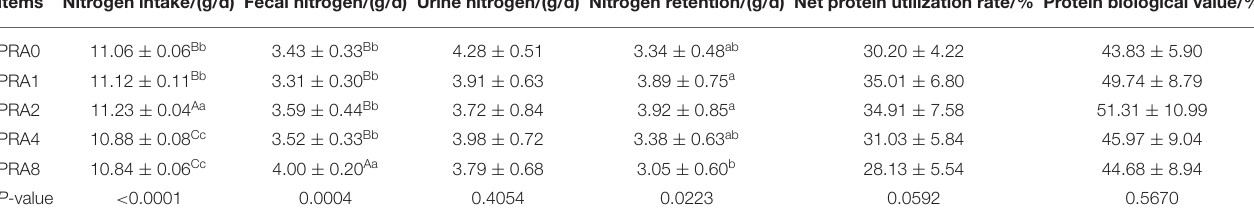
TABLE 4 | Effects of dietary PRA extract levels on nitrogen metabolism of raccoon